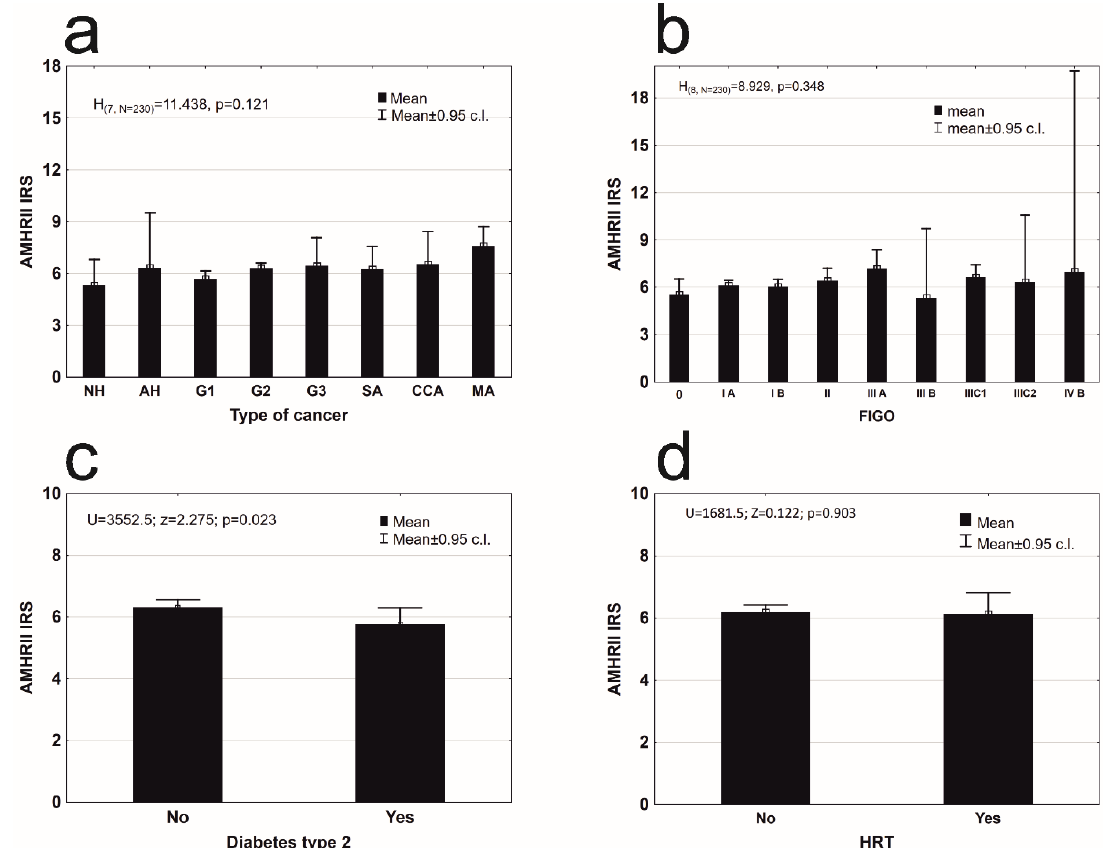
Figure 2. Mean AMHRII expression in: ( a ) different types of endometrial lesion (description of histopathological groups: NH, AH, G1, G2, G3, SA, CCA, MA in Table 1) (Kruskal–Wallis test, H (7, N =